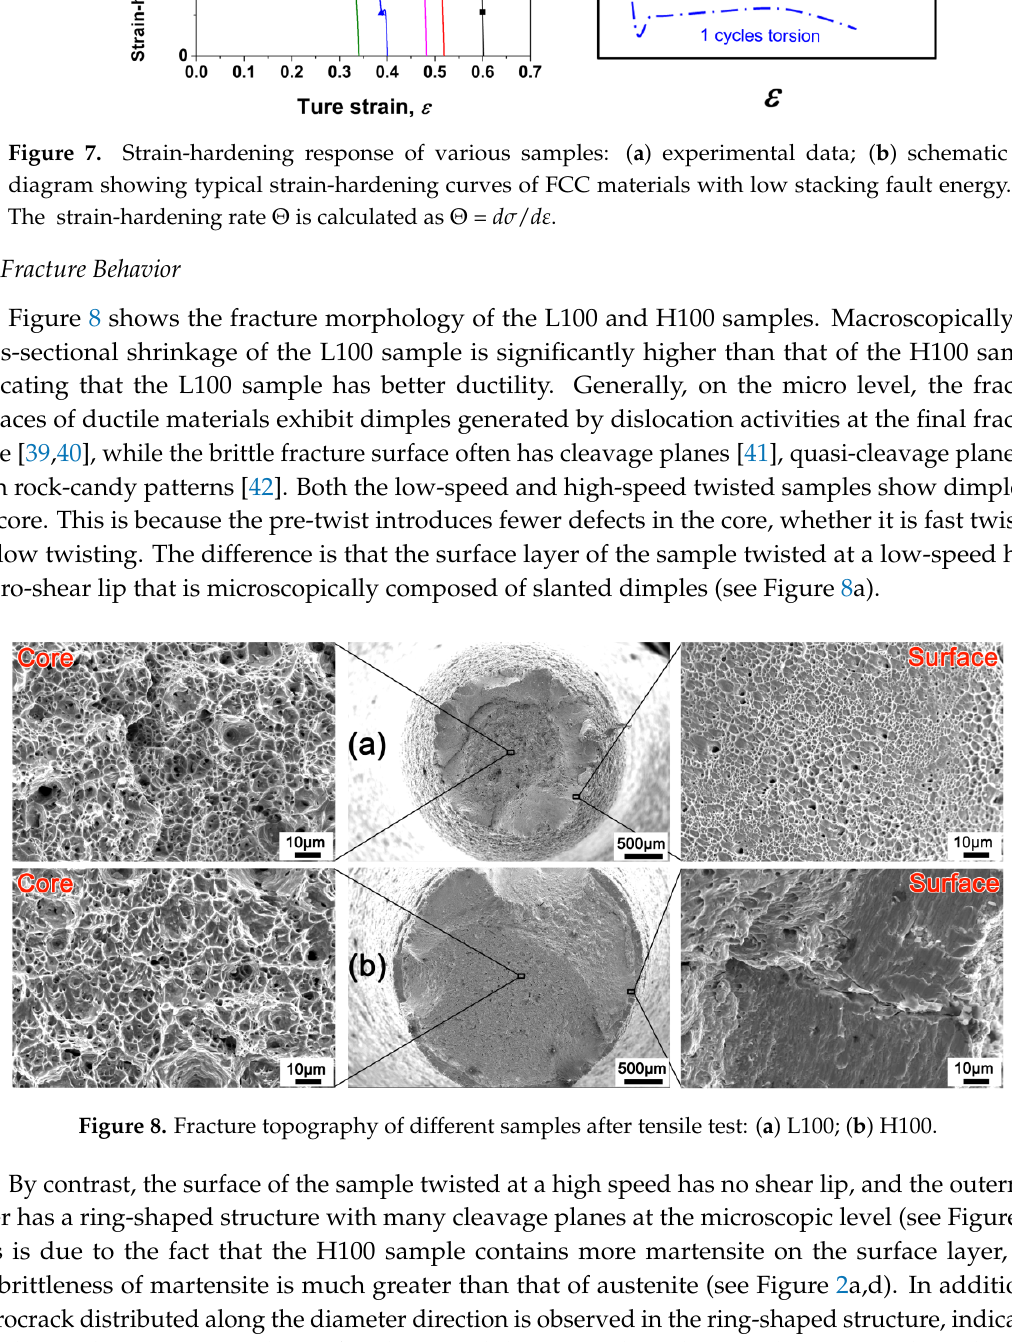
Figure 7. Strain-hardening response of various samples: ( a ) experimental data; ( b ) schematic diagram showing typical strain-hardening curves of FCC materials with low stacking fault energy. The strain-hardening rate Θ is calculated as Θ = dσ/d ɛ .